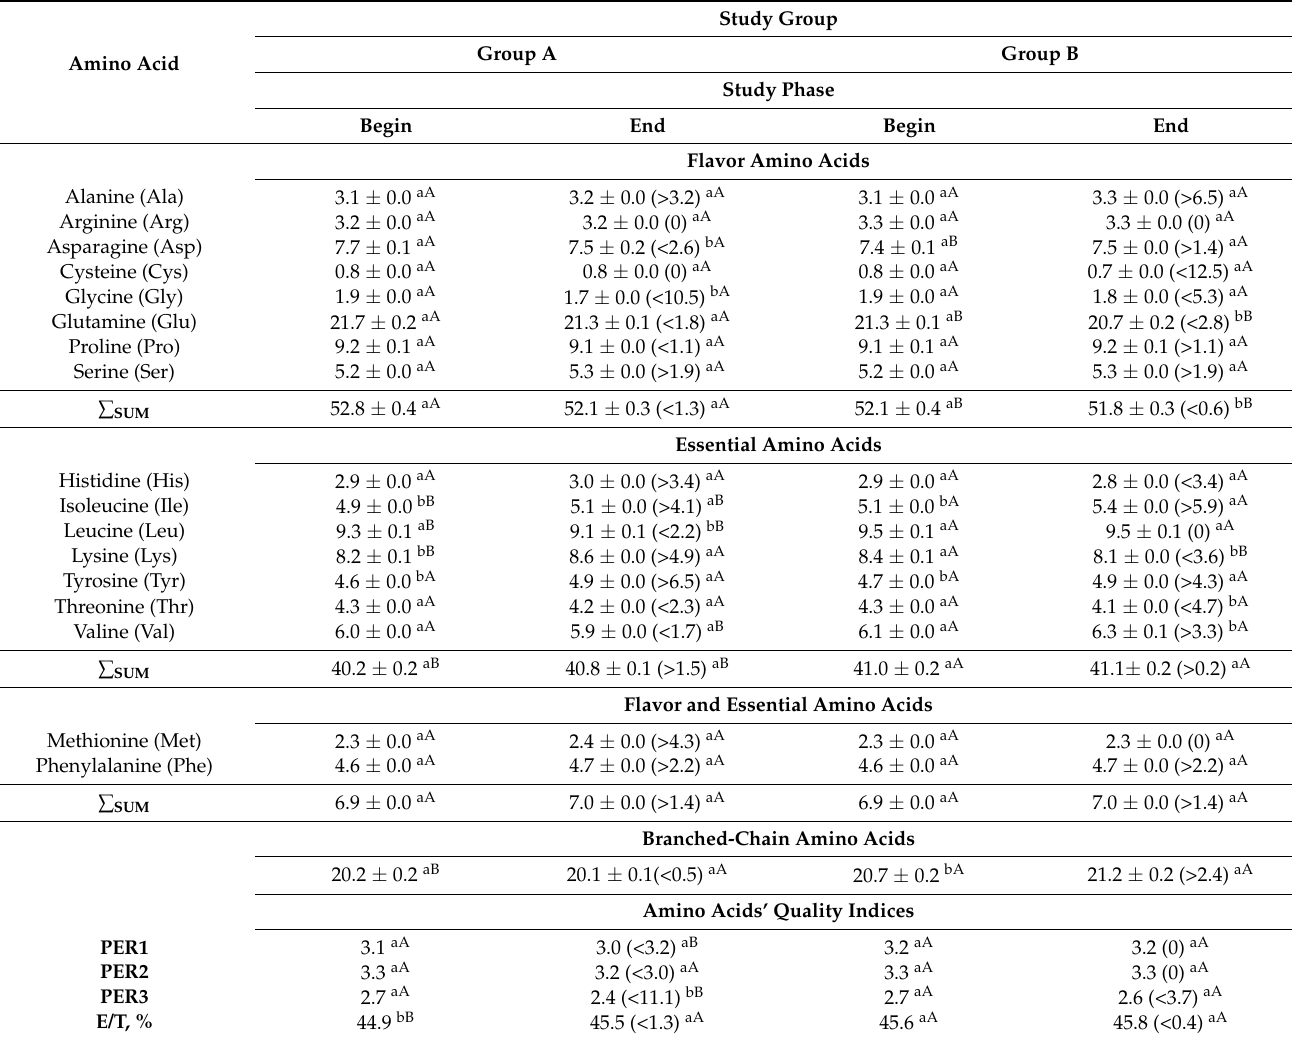
Table 4. The profiles of amino acids in milk protein and their comparison between the group and study phase, g 100 g − 1